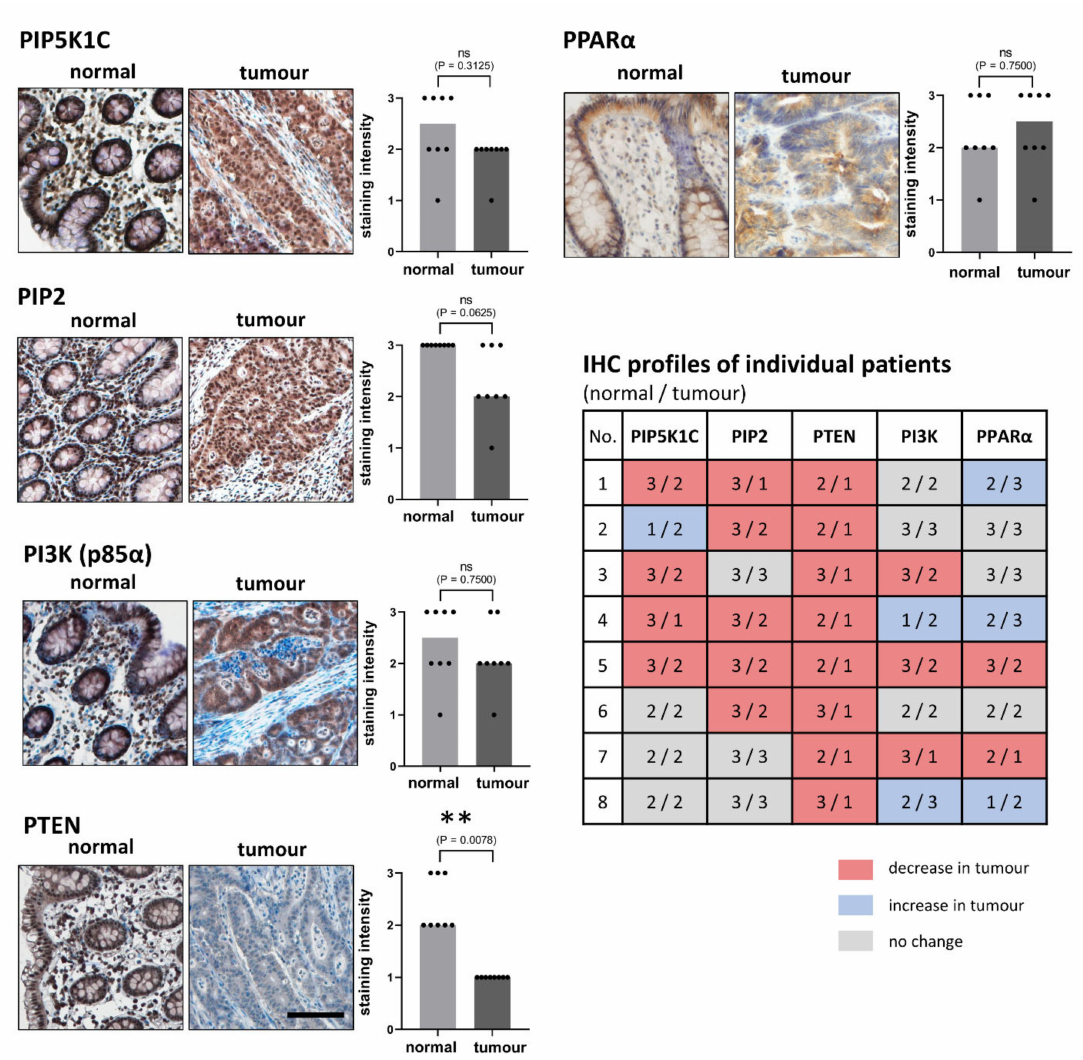
Figure 3. Immunohistochemical staining of PIP5K1C, PIP2, PI3K, PTEN, and PPAR α in normal and colorectal carcinoma samples. Representative microphotographs of poorly differentiated (grade 3) tumors and corresponding normal tissue samples were obtained from the same patient (male, 69 years old, no. 5). Magnification 100 × , black line represents 100 µ m. Graphs show immunohistochemical staining intensities ( n = 8): columns show medians, dots show individual samples. Immunostaining intensities were evaluated in semiquantitative manner as: 0 = negative staining, 1 = low staining, 2 = moderate staining, 3 = strong staining. Comparison of staining intensities between normal and carcinoma tissues was performed by Wilcox test at level of significance p ≤ 0.05. Statistically significant results are marked by (** p ≤ 0.01), p -values are given directly in graphs. Table represents individual IHC profiles of each patient, i.e., staining intensities for adjacent normal tissue/tumor, patient no. corresponds with their no. in Table 1. Note very similar patterns of changes between the expression of PPAR α and PI3K (p85 α